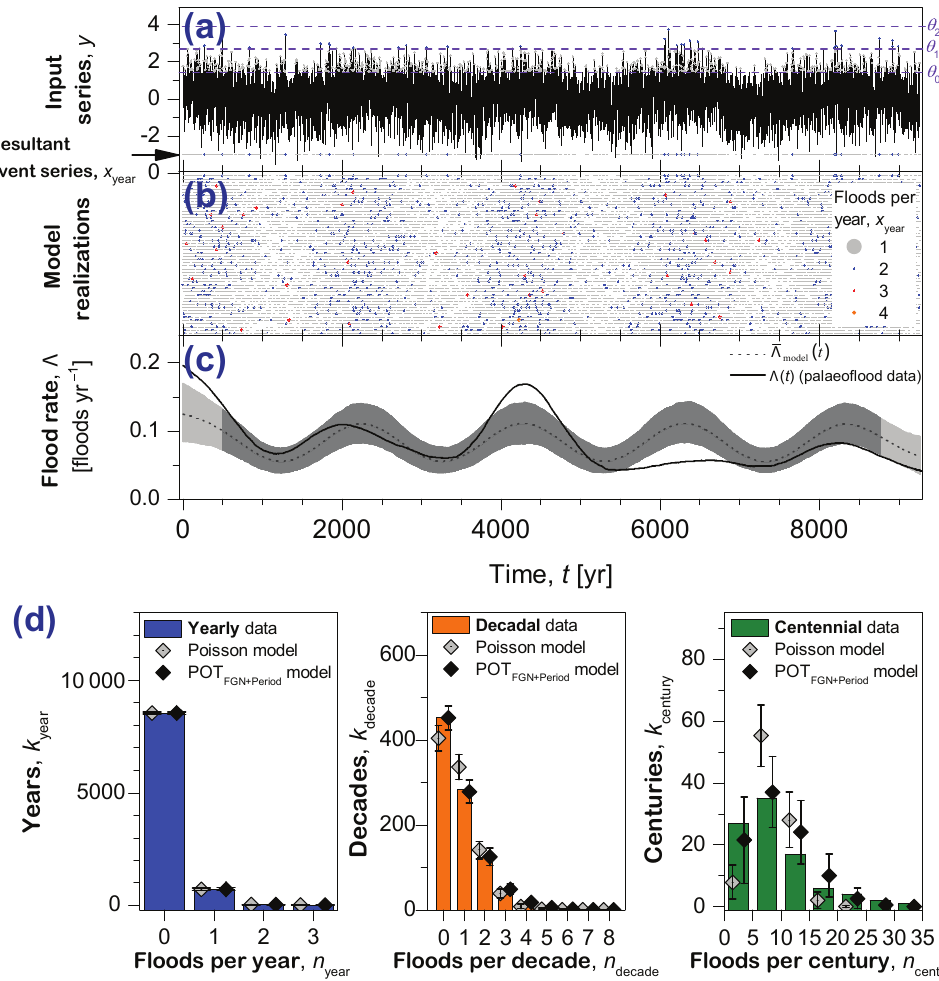
Figure 15. POT FGN + Period model with optimized parameters. (a) Shown (black time series) is a realization of a fractional Gaussian noise (FGN) with a long-range persistence strength of β model = 0 . 24 (normalized to a mean = 0.0 and variance = 1.0) that is superimposed with a periodic component (period: T = 2030years; amplitude: A = 0.30). This synthetic time series is given a time resolution of (cid:49)t = 1 year and a length N year = 9271 years. Peaks over thresholds (POTs) are considered (as in Fig. 12) for five thresholds (three shown here), θ 01 , θ 12 , etc., where input (FGN + period) values < θ 01 translate to x year = 0 floodyr − 1 , input values between θ 01 and θ 12 result in x year = 1 floodyr − 1 , etc. The resultant model series of the number of floods per year (grey and blue circles) for 9271 years is constructed to have a Poissonian one-point distribution and is shown at the bottom of (a) . (b) Shown are 50 more model realizations of the POT FGN + Period model as number of floods per year (see the legend for the colour code), with maximum x year = 4 floods yr − 1 . (c) Time-dependent flood rate (cid:51)(t) given as a function of time t (see Fig. 11a, text and Appendix C) using 1000 model realizations similar to (b) . We first compute a kernel density estimator for each of the 1000 model realizations. Then we take the mean of these at each time step, giving us a mean (cid:51)(t) (dashed black line). We then compute the 95% confidence band limits (dark grey bands), by ordering the 1000 values of (cid:51)(t) for each time step t and choosing the 25th and 975th values. As the flood rate of the first and last 500 years might be affected by edge effects, the corresponding dark grey colour banding is changed to light grey. For a comparison, the corresponding time-dependent flood rate for the palaeoflood data (solid black line), as shown in Fig. 11a, is given. (d) Black diamonds represent the mean number of floods per year, decade, and century based on 1000 realizations of our POT FGN + Period model as given in the previous panels, with error bars 95% confidence intervals. For comparison are shown (i) the histogram (also shown in Fig. 6a) of the original palaeoflood time series number of floods per year (blue bars), decade (orange bars), and century (green bars), and (ii) the corresponding Poisson model (grey diamonds, also shown in Fig. 6a) with respective rate parameters λ year = 0 . 083 floods yr − 1 , λ decade = 0.83 floods decade − 1 , and λ century = 8 . 3 floods century − 1